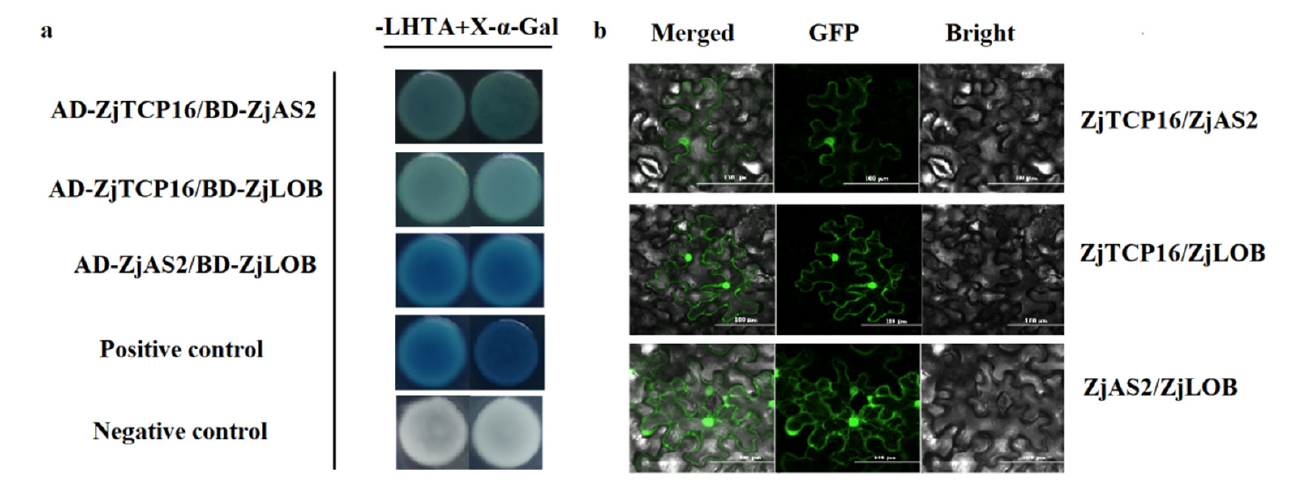
Figure 6. ZjTCP16 interacted with ZjAS2 and ZjLOB in both cytoplasm and nucleus. ( a ): Y2H assays between ZjTCP16, ZjAS2 and ZjLOB. ( b ): BiFC assays between ZjTCP16, ZjAS2 and ZjLOB. In the top two panels, ZjTCP16 was fused to pNC-BiFC-Enn, and ZjAS2 or ZjLOB were fused to pNC- BiFC-Ecn, while in the lowest panel, ZjAS2 was fused to pNC-BiFC-Enn. Bars, 100 μ m. 3.6. ZjTCP16 Altered the Expression Levels of Genes Involved in Plant Morphogenesis